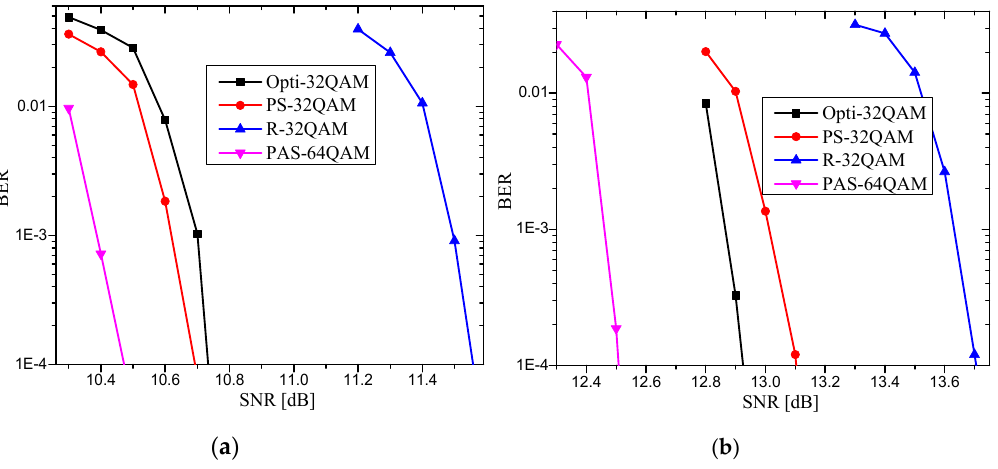
Figure 8. BER versus SNR performances in the scenarios of ( a ) C = 3.33 b/s, ( b ) C = 4 b/s.